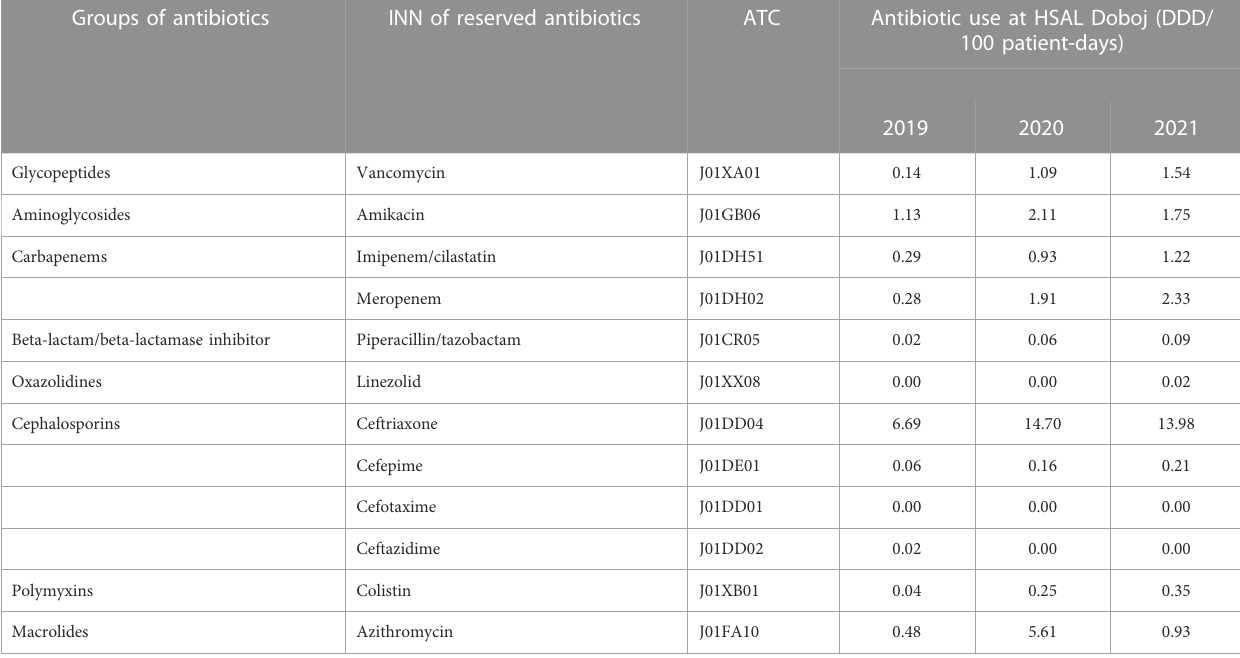
TABLE 6 De fi ned daily dose per 100 patient-days of antibiotics before (2019) and during the pandemic (2020 and 2021) in HSAL Doboj per year. Groups of